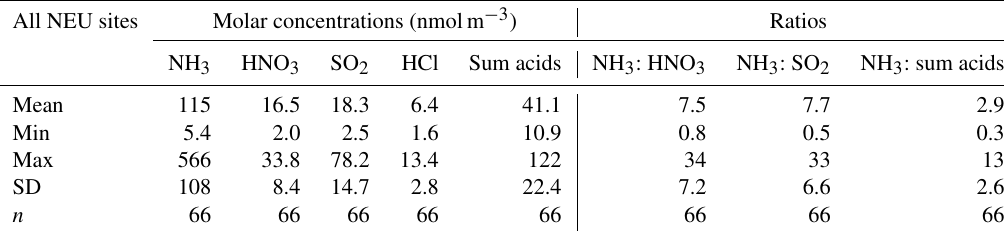
Table 6. Mean molar concentrations of gases and NH 3 : acid gas ratios measured at sites ( n = 66) in the NEU DELTA ® network.